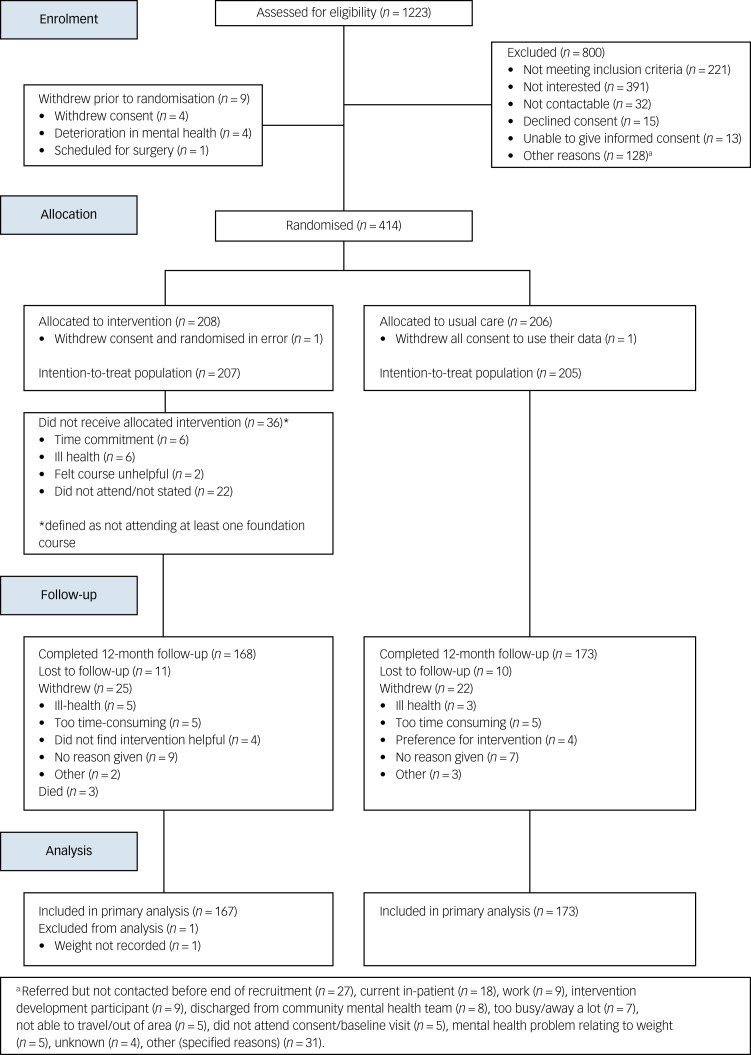
STEPWISE trial CONSORT diagram.